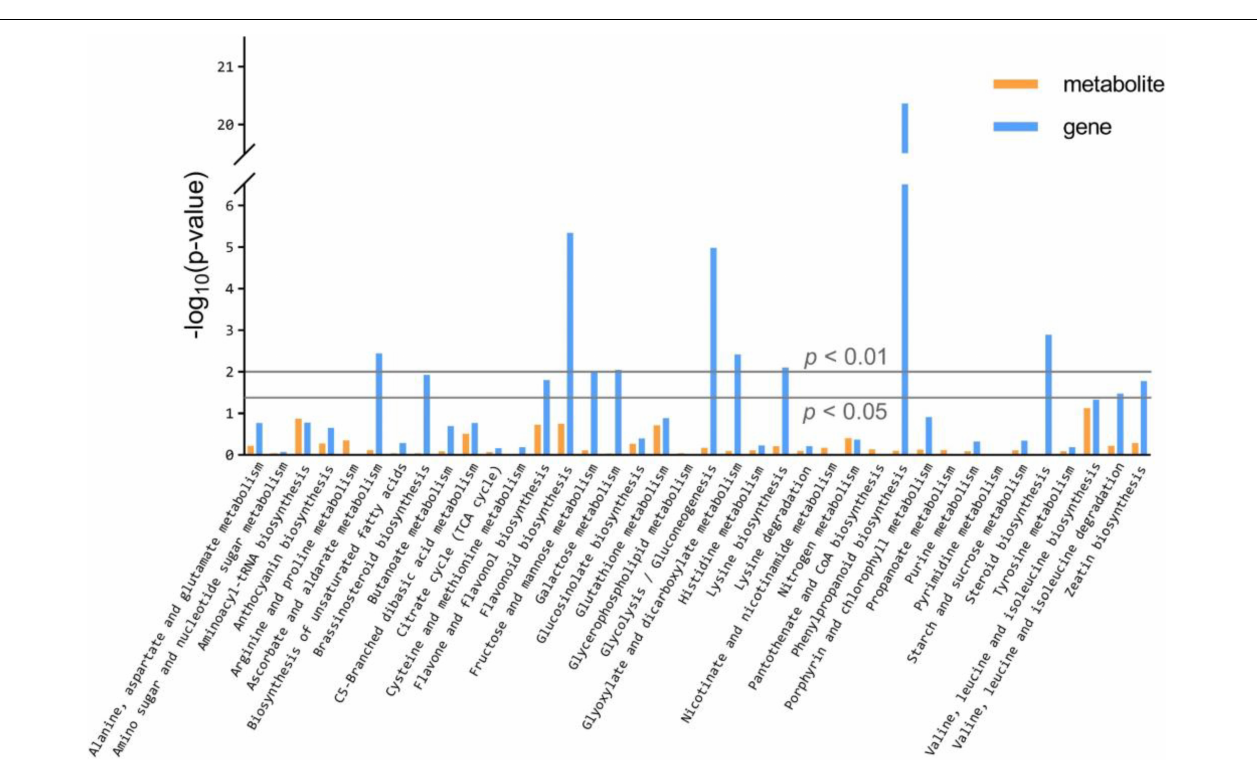
FIGURE 5 | KEGG enrichment analysis of the DEGs and DAMs which were enriched in the same